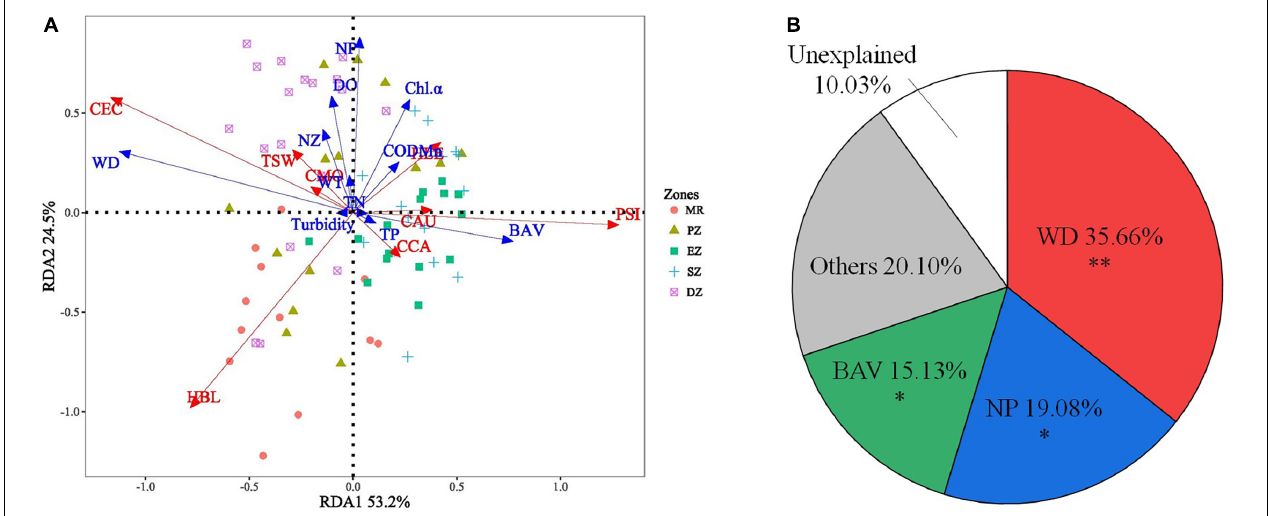
FIGURE 6 | Results from the redundancy analysis (RDA) identifying the key environment variables explaining differences in the relative abundance of dominant fish species among the Mangshe River (MR) and purification zones of Lake Yanlong (A) . The pie chart (B) describes results from the hierarchical portioning analysis (HP) characterizing the amount of independent explanatory power of each key environmental variable identified. WT, water temperature; WD, water depth; TN, total nitrogen; TP, total phosphorus; COD Mn , chemical oxygen demand; Chl- α , Chlorophyll- α concentration; DO, dissolved oxygen; BAV, biomass of aquatic vegetation; NZ, density of zooplankton; NP, density of phytoplankton; CAU, Carassius auratus ; CCA, Cyprinus carpio ; CMO, Culter mongolicus ; HBL, Hemiculter bleekeri ; PSI, Pseudobrama simony ; HLE, Hemiculter leucisculus ; TSW, Toxabramis swinhonis ; CEC, Coilia ectenes , ∗ = 0.01 < p < 0.05, ∗∗ = 0.001 < p < 0.01.